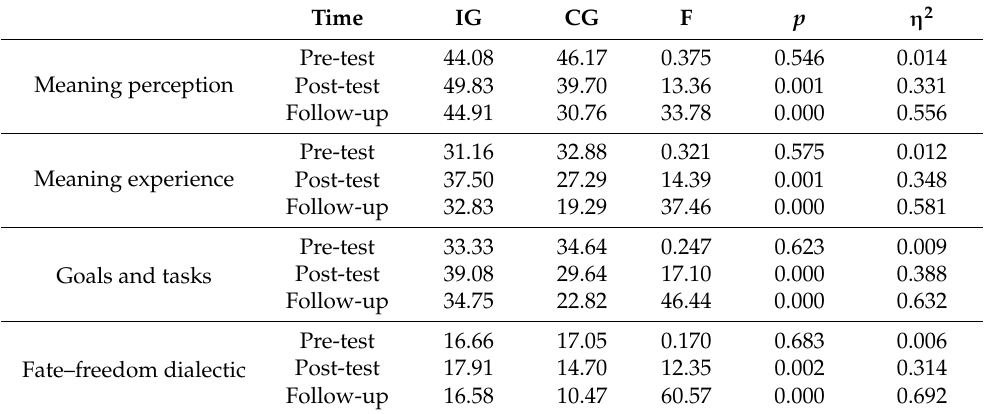
Table 3. Mean meaning of life dimensions at the three time measures and univariate comparison statistics in the IG and